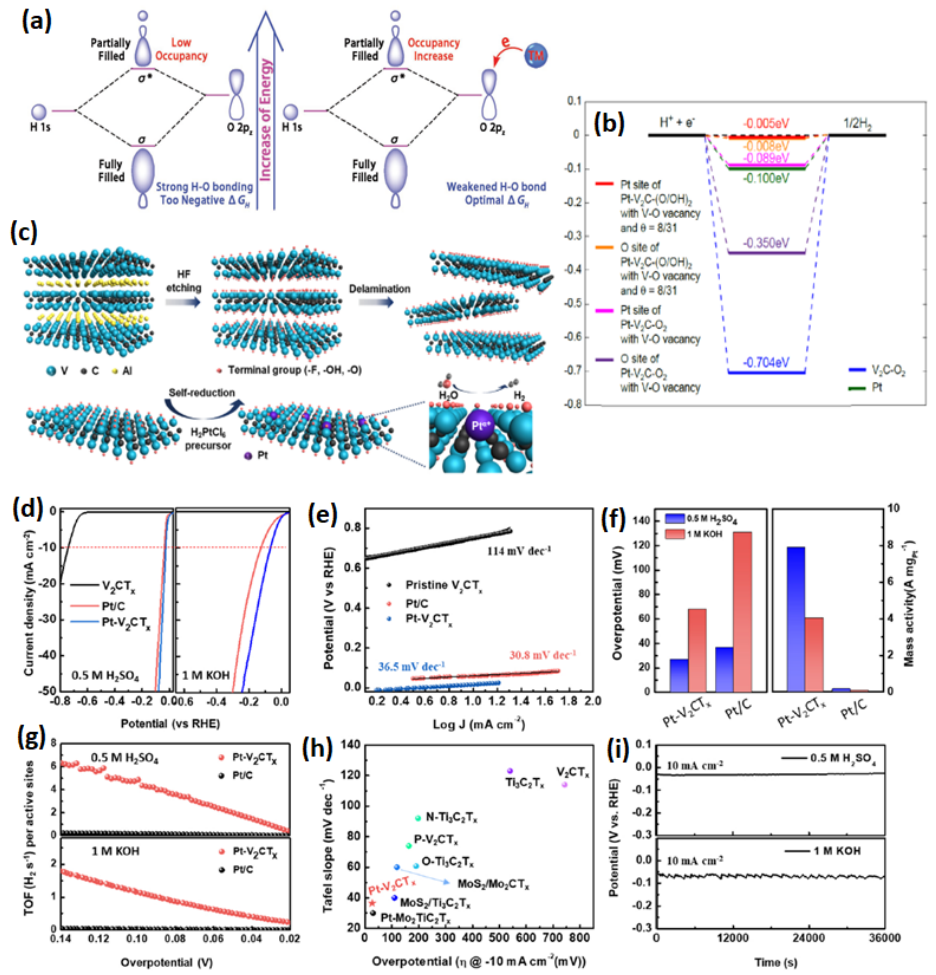
Figure 11. The scheme of modulating the HER performance of V 2 CO 2 by introducing transition metal onto the surface. ( a ) The combination of H 1s orbital and O 2pz orbital forms a fully filled bonding orbital and a partially filled anti-bonding orbital, in which the occupancy of anti-bonding orbital will determine the strength of H O bond. ( b ) Structural characteristics of Pt-V 2 CT x nanosheets (Adapted from Ref. [95] Open access). ( c ) Schematic illustration for synthesis of Pt-V 2 CT x nanosheets. Electrocatalytic performance for Pt-V 2 CT x and reference HER electrocatalysts. ( d ) HER polarization curves of pristine V 2 CT x , Pt/C (20%) and Pt-V 2 CT x , acquired using graphite rod as the counter electrode in 0.5 M H 2 SO 4 solution (left) and in 1 M KOH solution (right). ( e ) Corresponding Tafel slope derived from a. ( f ) Comparison of overpotential (10 mA cm − 2 ) and mass activity for Pt/C (20%) and Pt-V 2 CT x catalysts in 0.5 M H 2 SO 4 (blue) and 1 M KOH (red). ( g ) Turnover frequency (TOF) of Pt/C (20%) and Pt-V 2 CT x in 0.5 M H 2 SO 4 solution (top) and in 1 M KOH solution (bottom). ( h ) Comparative graph for overpotential of related MXene-based HER electrocatalysts in acidic